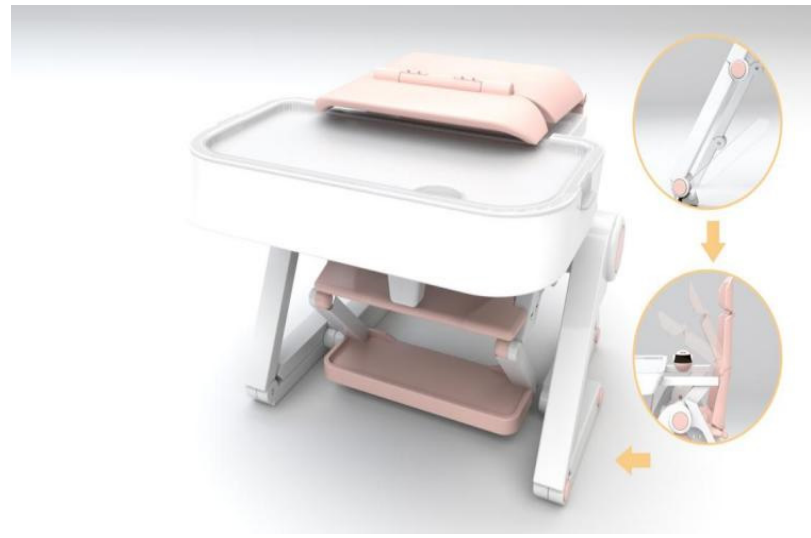
Figure 9. Storage mode.